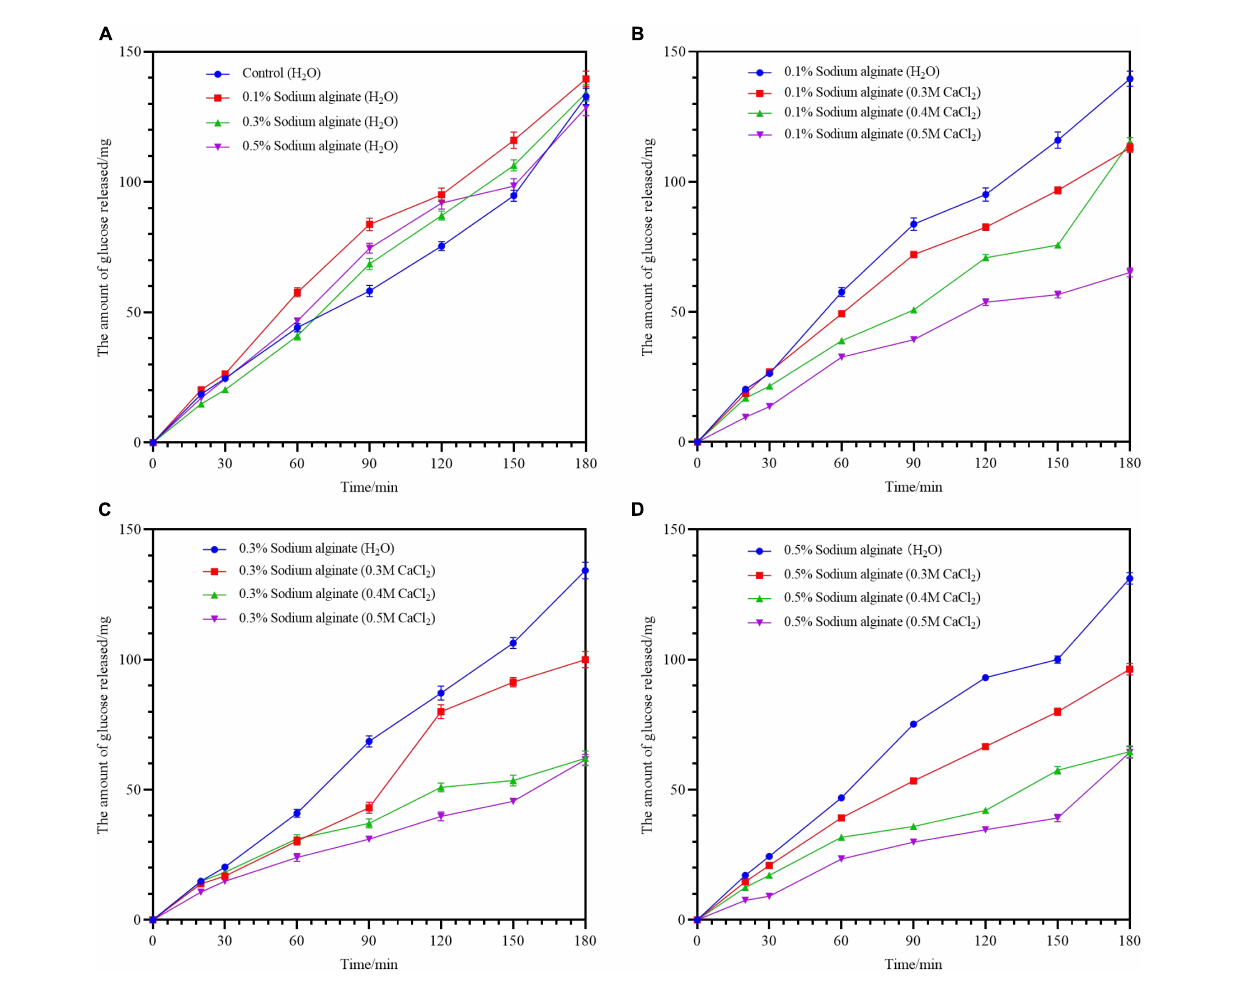
FIGURE3 (A–D) Show the effects of varying Ca 2 + concentrations of the digestibility of buckwheat noodles prepared by the exogenous method. Control group panel (A) was steamed with deionized water. The experimental groups panels (B–D) were steamed with calcium chloride solution of different